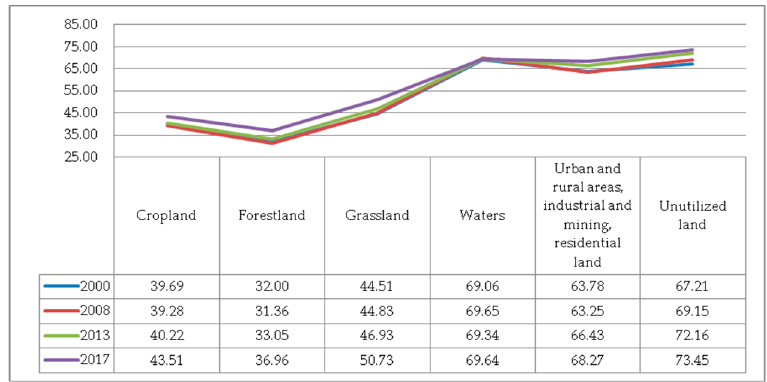
Figure 9. The Aggregation Index (AI) of various types of landscape. Figure 10. The Interspersion and Juxtaposition index (IJI) of various types of landscape.